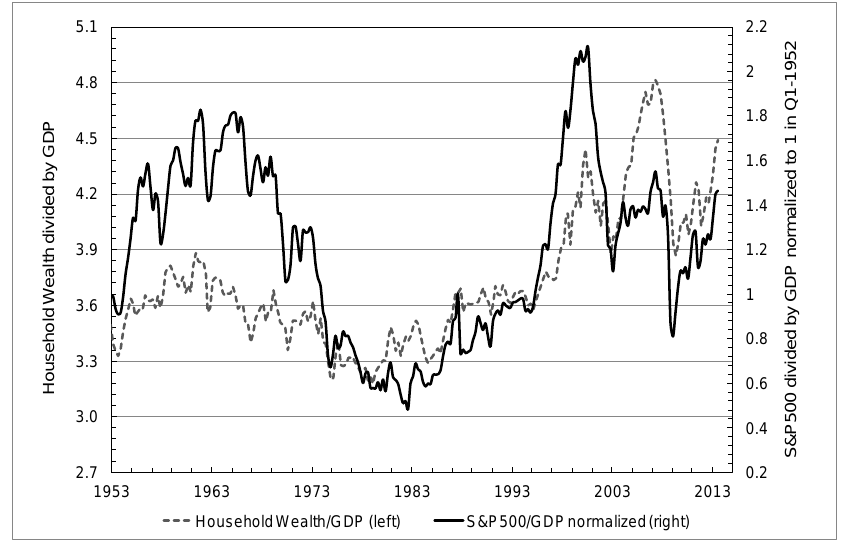
Figure 2. The U.S. stock market performance (continuous line) and the household net worth in the U.S. (dashed line) in units of GDP from 1953 to Q2 2013. The household net worth includes real estate and financial assets (stocks, bonds, pension reserves, deposits, etc. ) net of liabilities (mostly mortgages). The graph uses the Fed’s Q2 2013 Flow of Funds data